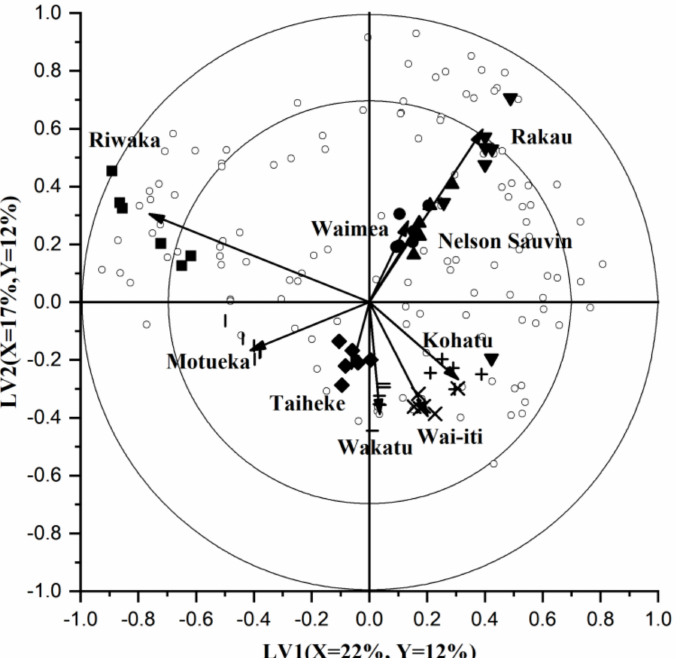
Figure 2. Partial least squares discriminant analysis (PLS-DA) bi-plot of nine commercial New Zealand hop cultivars using the first two latent variables (LV). X- and Y-variance explained by each LVs is also listed. Unfilled circles show the volatile compounds selected through gas chromatography mass spectrometry (GC-MS). Solid shapes represent the analytical replicates of each cultivar. Vectors represent contribution to the correlation coefficients for each cultivar. Rings represent correlation coefficients at 70% and